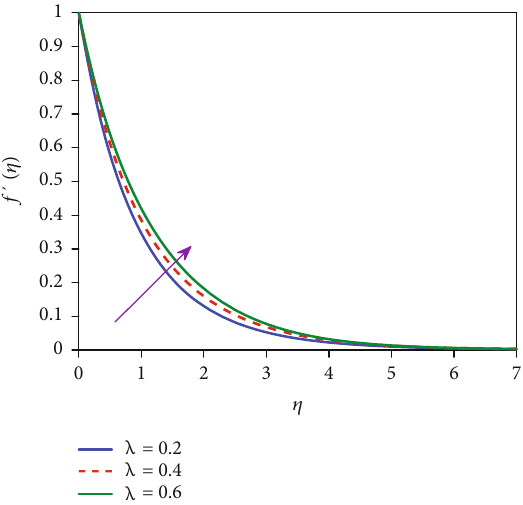
on the secondary velocity g ð η Þ i